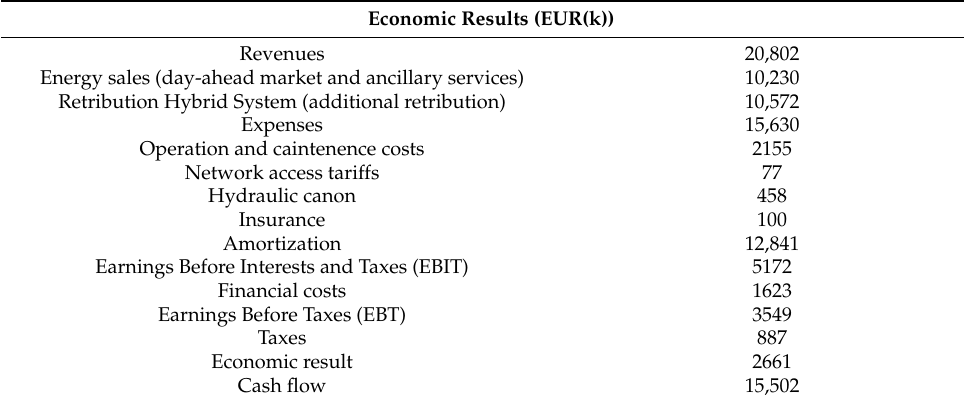
Table 4. Economic results of the hybrid